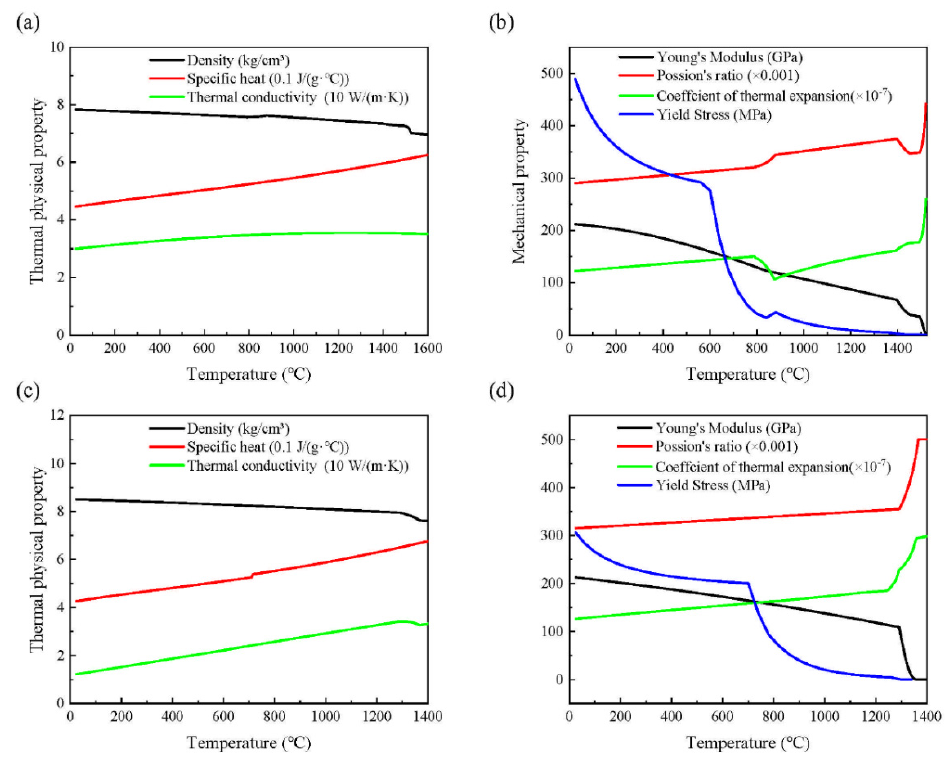
Figure 5. Temperature-dependent material properties of T23 steel and Inconel 82 weld metal: ( a ) thermal physical properties and ( b ) mechanical properties of T23 steel; ( c ) thermal physical properties and ( d ) mechanical properties of Inconel 82.